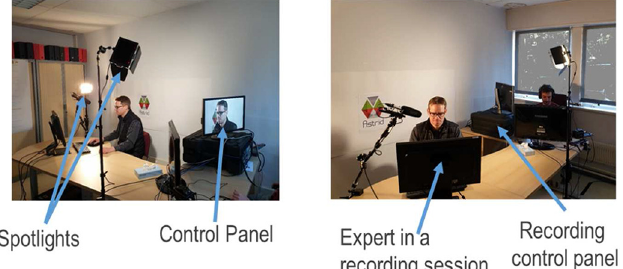
Fig. 4. Third step of a MOOK creation (cid:1) Video-Recording of the presentation (here in a remote video Lab).